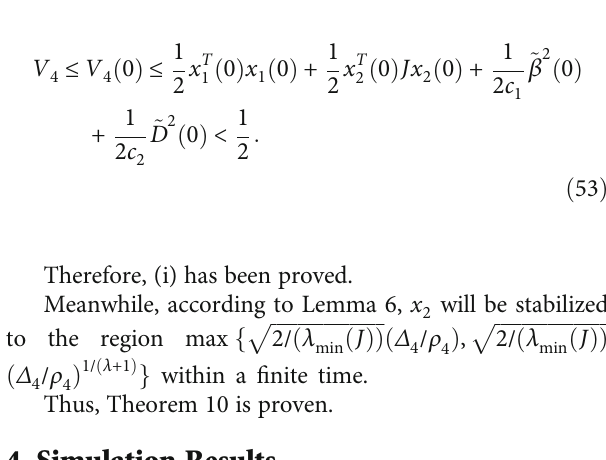
Figure 7: Estimation of γ